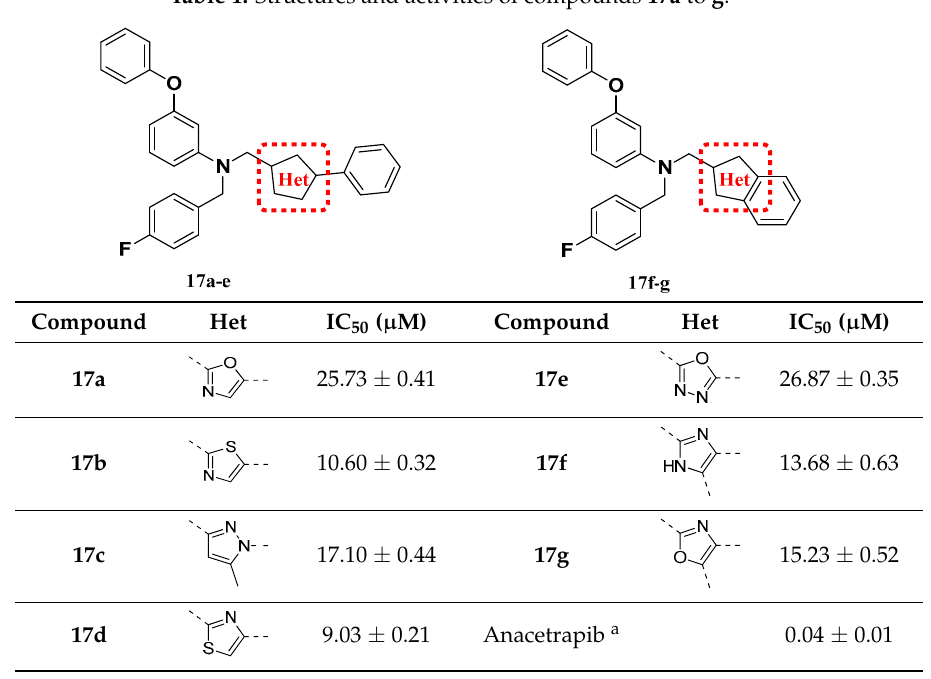
Table 1. Structures and activities of compounds 17a to g .